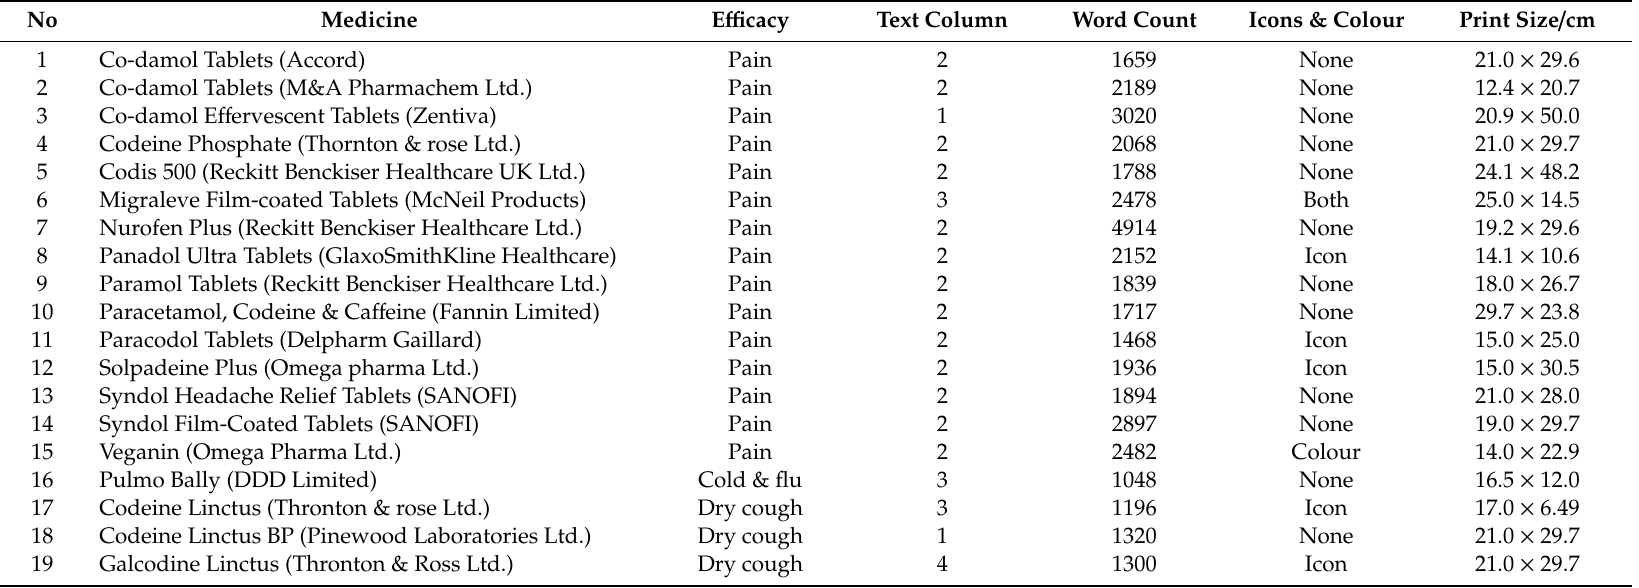
Table 2. Analysis of the patient information leaflets (PILs) of over-the-counter (OTC) codeine containing medicines collected for case